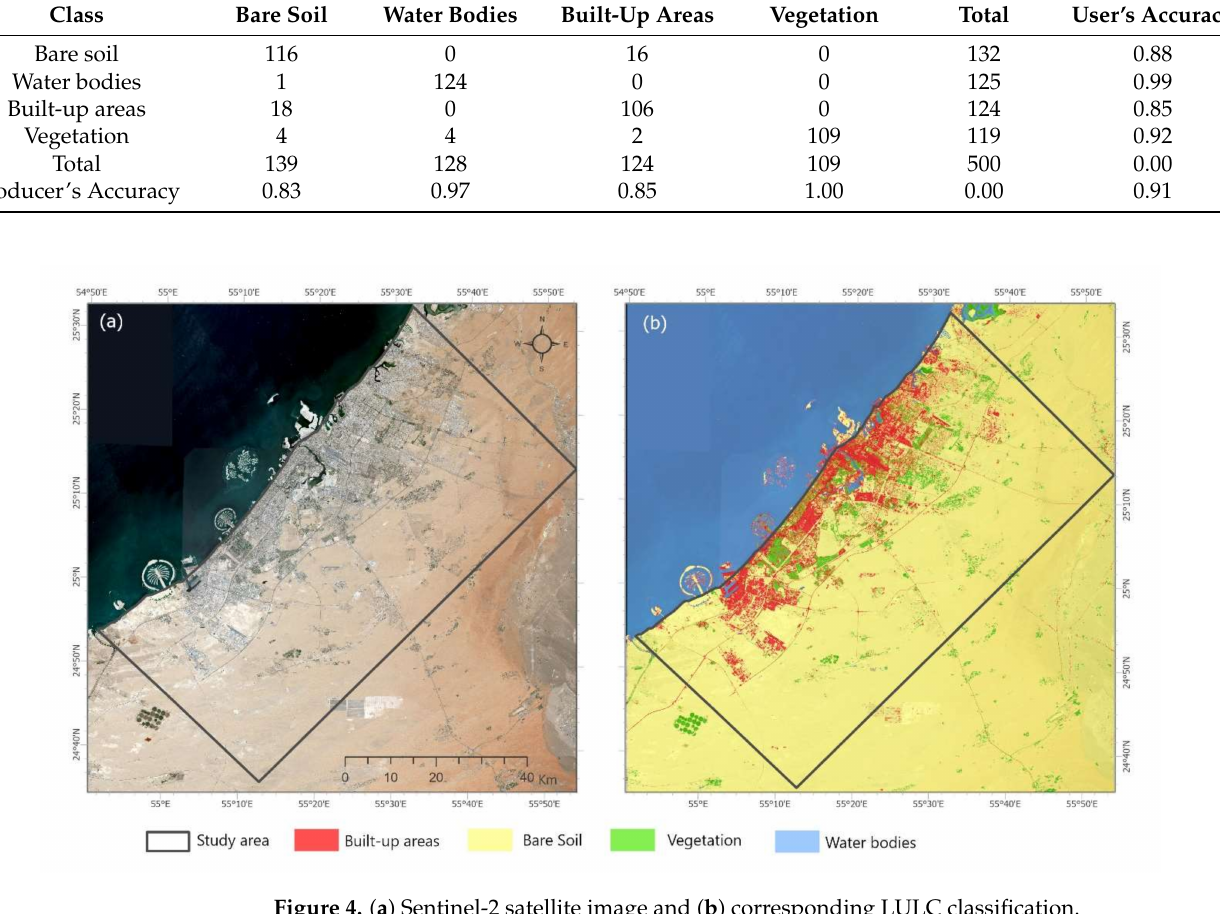
Figure 4. ( a ) Sentinel-2 satellite image and ( b ) corresponding LULC